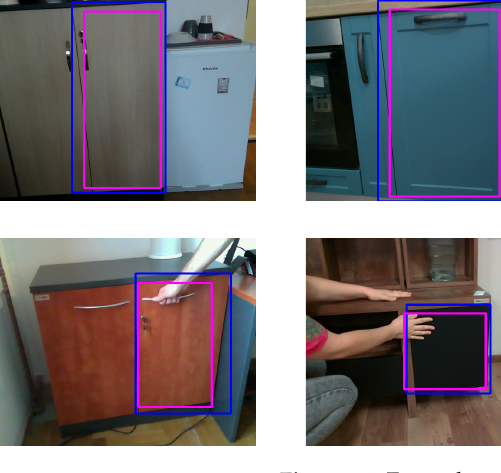
Figure 14. Examples of ROIs correctly predicted by YOLOv7. The ground truth bounding boxes are shown in blue, while the predicted bounding boxes are shown in magenta.